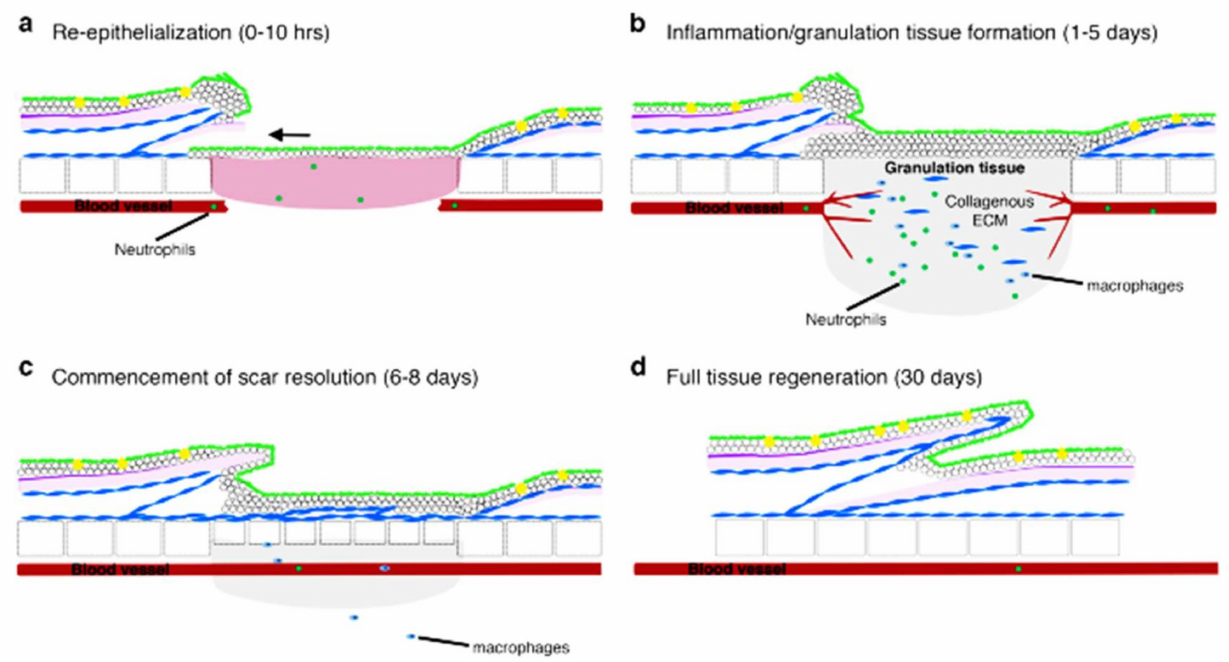
Figure 3. Mechanism of wound healing in zebrafish. Figure is re-used under the permission obtained from licensed under a Creative Commons Attribution 4.0 International License